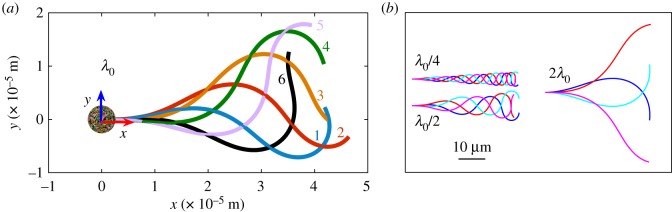
(a) Swimmer body shape at six evenly spaced times within one period of π10−2 s. The head is spherical of diameter Lhead = 5 × 10−6 m, the flagellum length is 50 × 10−6 m, and the tail beating is given by formula (2.21). This shape corresponds to the reference wavelength λ0. (b) Flagellum centreline for four evenly spaced times within one beating period and three different wavelengths: λ = λ0/4, λ0/2, 2λ0.